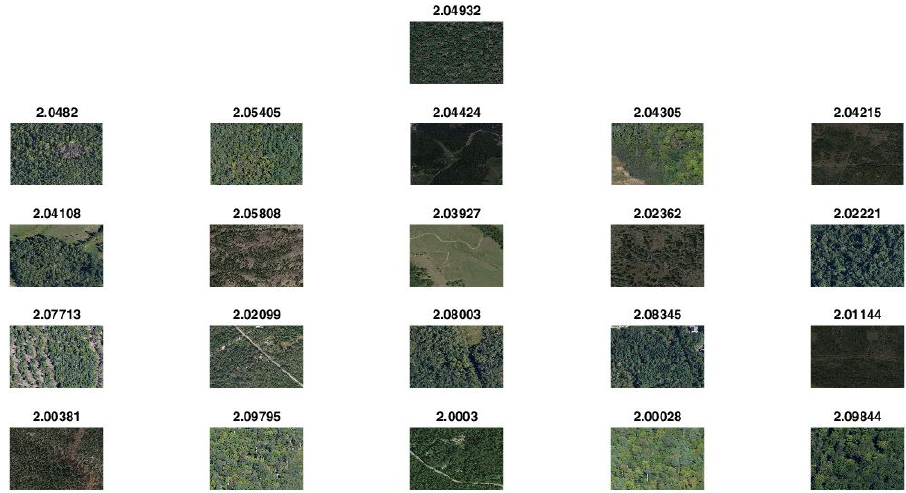
Figure 17. Results of image retrieval for the semantic class “Forest”.